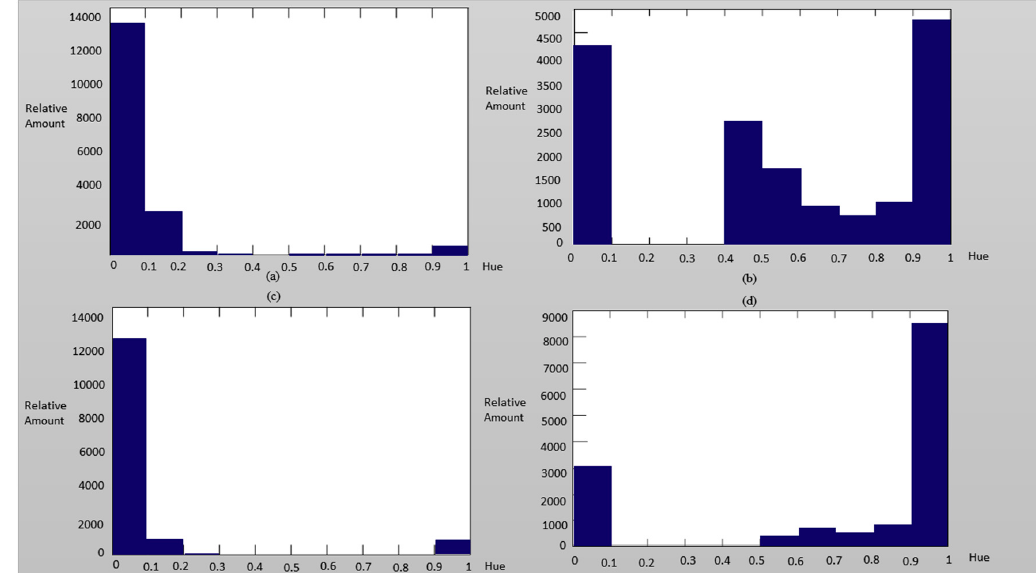
Figure 11. The hue distribution of the authentic image of ( a ) nose, ( c ) mouth,) and the spoofed image of ( b ) nose, ( d ) mouth as examples.